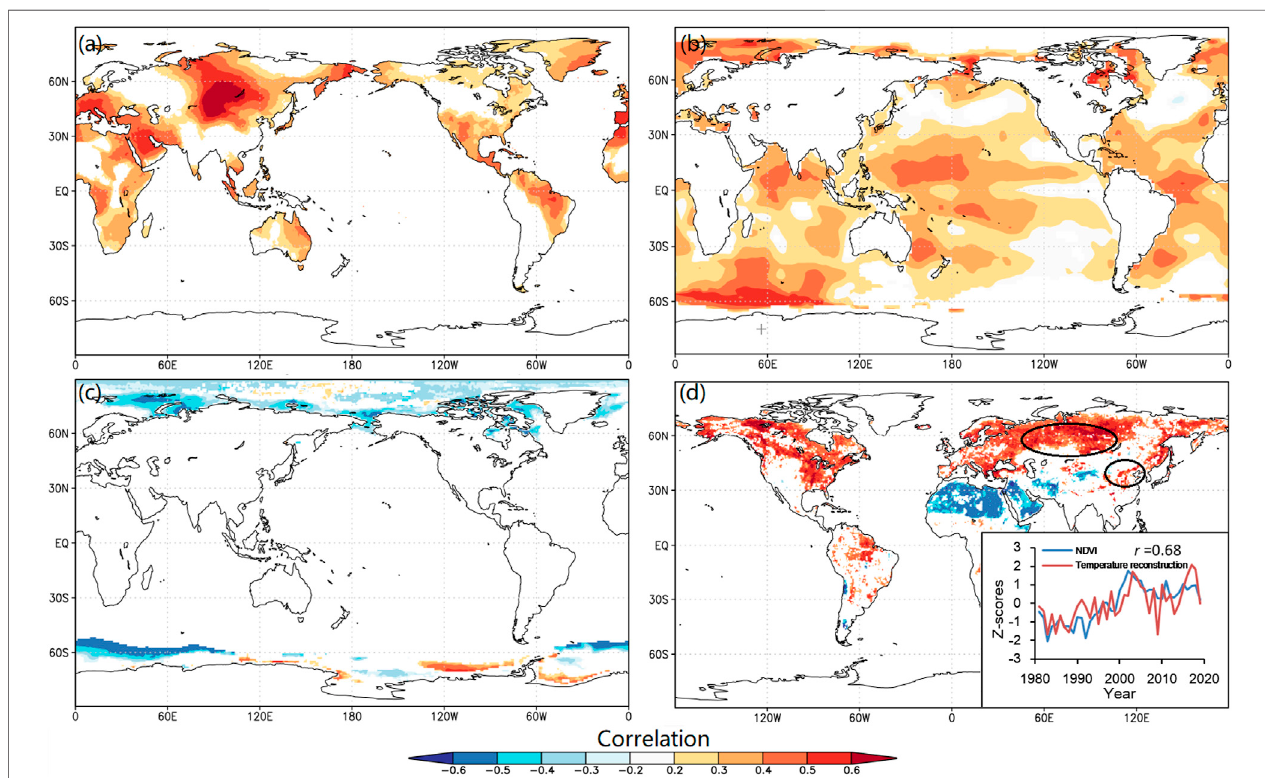
FIGURE 6 | Spatial correlation patterns of temperature reconstruction with CRU temperature (A) , (1955 – 2018), SSTs (B) , (1854 – 2019), sea ice (C) , 1870 – 2019) and NDVI (D) , 1981 – 2019) for the common periods. Note that only correlations ( p < 0.05) are shown in this fi gure. Comparison between the Normalized (z-score) NDVI series and the temperature reconstruction is shown in the inside panel of (D)